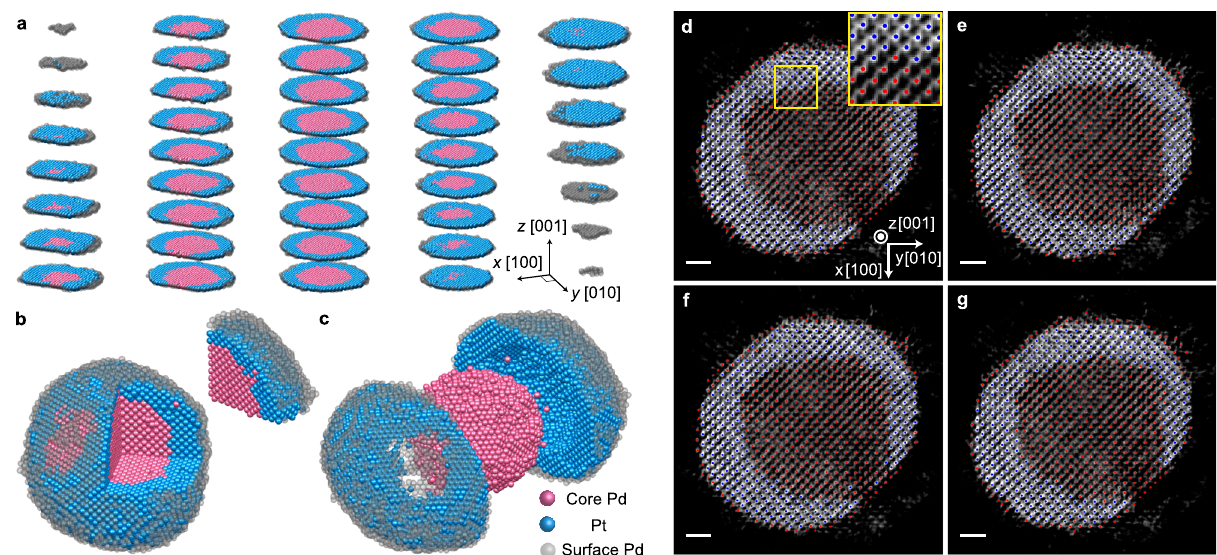
Fig. 1 | Experimentally determined 3D atomic structure of a Pd@Pt core-shell nanoparticle. a Atomic layer slices along the [001] crystallographic direction, to showtheoverallcore-shellstructure. b Overall3Dviewofthenanoparticlewithone octant of the sphereseparated tovisualizethe core-shellarchitecture. c Overall3D structurewithseparatedcoreandshell.Theshelliscutinhalfshowingthecoreand shell interface structure. d – g 1.06Å thick slices of the 3D tomogram, showing four